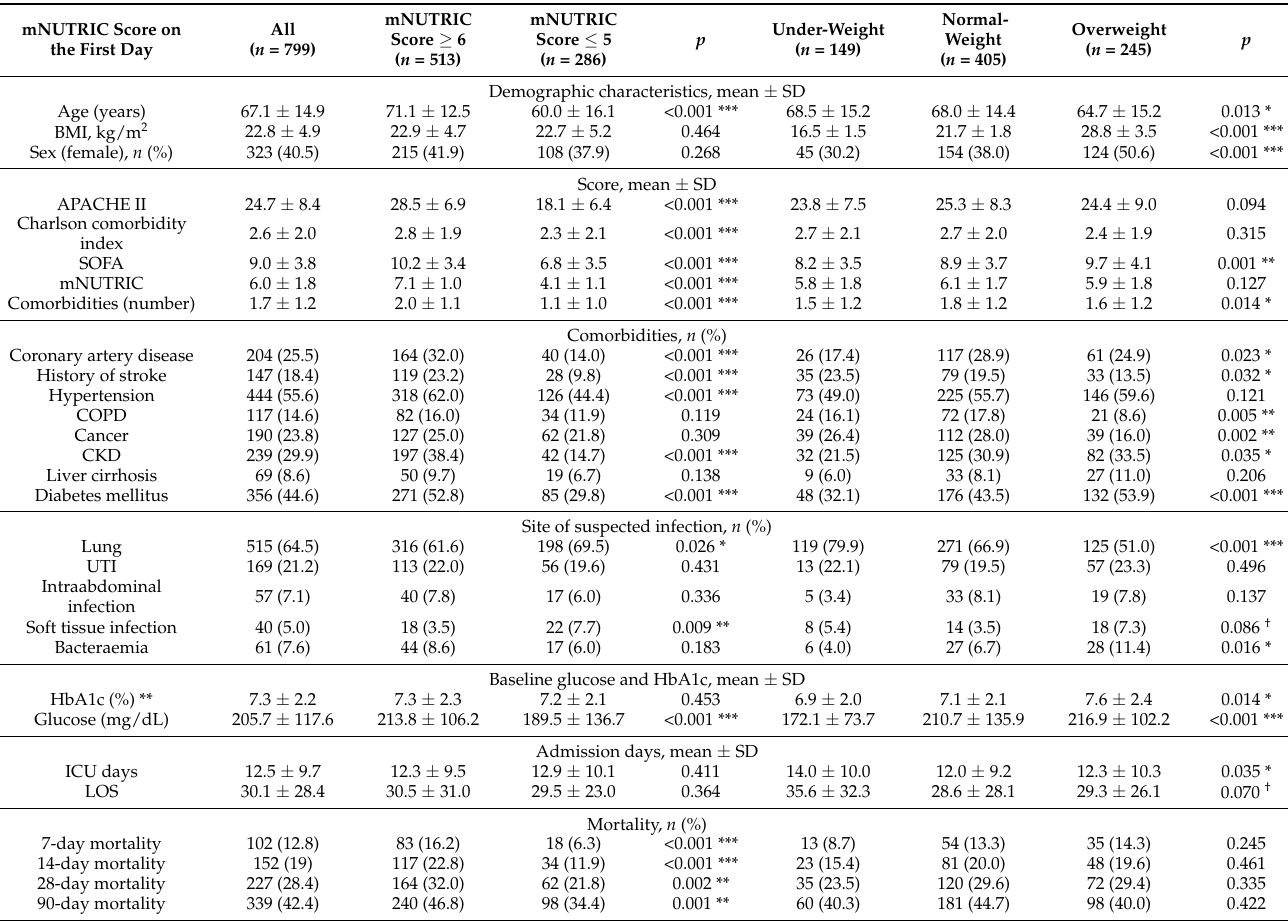
Table 2. Baseline characteristics and outcomes of the patients with sepsis in the construction cohort of the study. mNUTRIC Score on the First